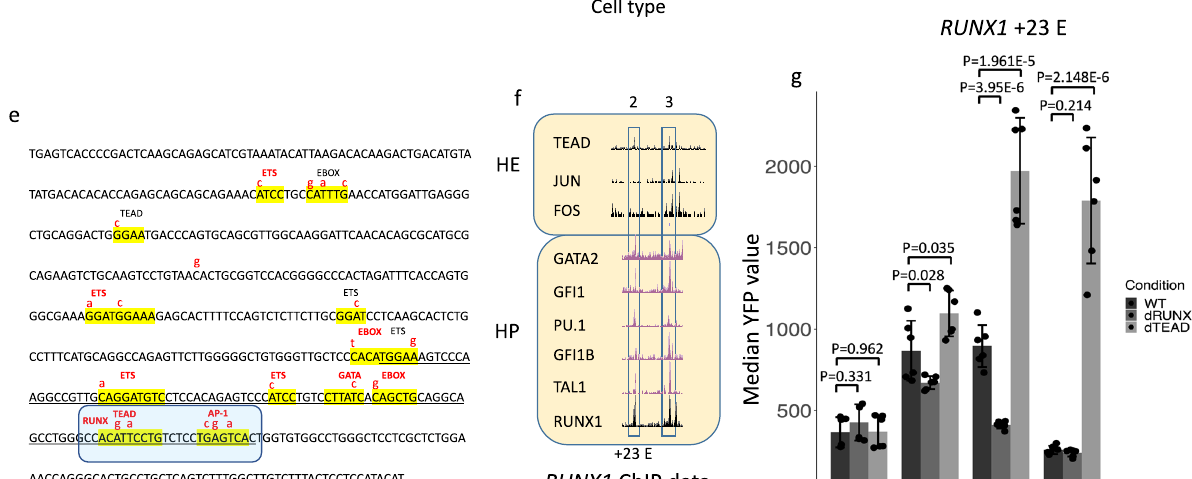
Dots showing individual values for n =3 biologically independent experiments. e Sequence of the Galnt1 enhancer with TF binding motif mutations indicated in red. Strong consensus sequences are highlighted in red. Source data are provided asaSourceData fi le. f Chipdatashowingthebindingoftheindicatedtranscription factors to RUNX1 enhancers in HE and HP cells. g Effect of mutations of the TEAD andRUNX1bindingsitesontheindividualactivityofthe RUNX1 +23kbenhancerin serumculture.Dataarepresentedasmeanvalues+/ − SD.Dotsshowingindividual values for n =6 biologically independent experiments. P -values calculated using a two-sided Student ’ s t -test. Source data are provided as a Source Data fi le.